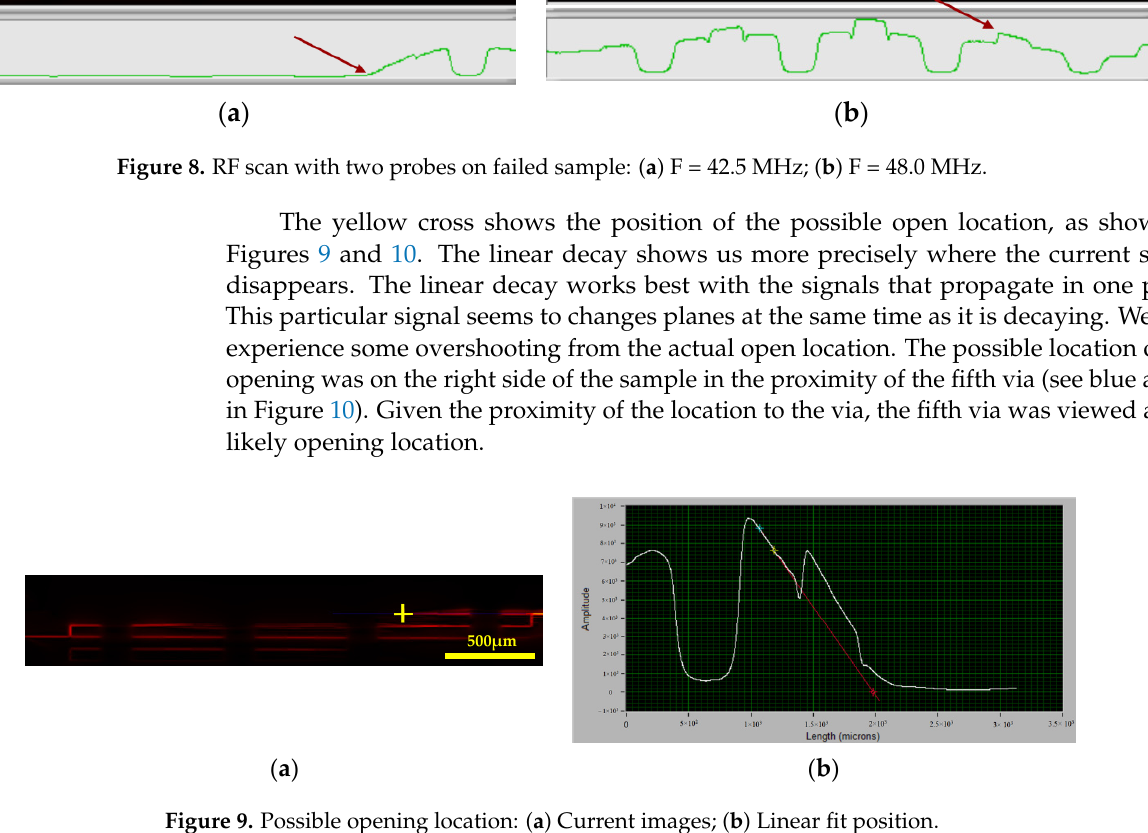
Figure 9. Possible opening location: ( a ) Current images; ( b ) Linear fit position.